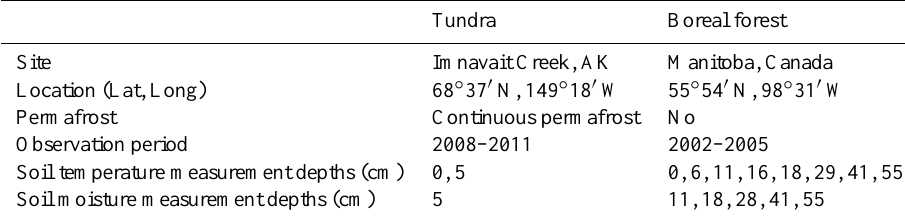
Table 1. Characteristics of two selected tundra and boreal forest tower sites used for model validation. Three tundra types are represented by the tower measurements at Imnavait Creek, Alaska, including dry heath, moist acidic tussock and wet sedge tundra. The boreal forest site encompasses a set of tower eddy covariance (EC) sites and measurements spanning a regional fire chronosequence at various succession stages in central Manitoba,